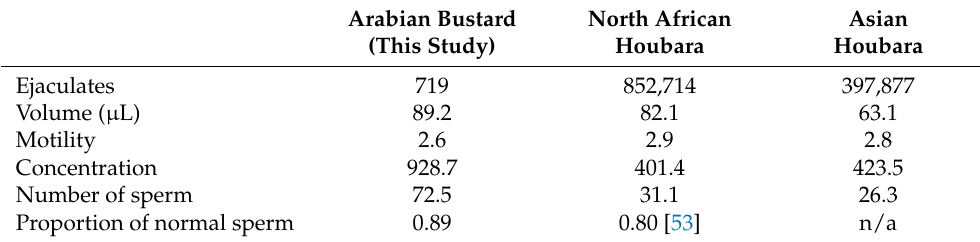
Table 4. Average semen characteristics for three bustard species bred within IFHC Conservation breeding programs: Arabian bustard (NARC, this study), North African houbara (ECWP, Morocco, unpublished data) and Asian houbara (NARC, unpublished data). Arabian Bustard North African Asian (This Study) Houbara Houbara Ejaculates 719 852,714 397,877 Volume ( µ L) 89.2 82.1 63.1 Motility 2.6 2.9 2.8 Concentration 928.7 401.4 423.5 Number of sperm 72.5 31.1 26.3 Proportion of normal sperm 0.89 0.80 [53]